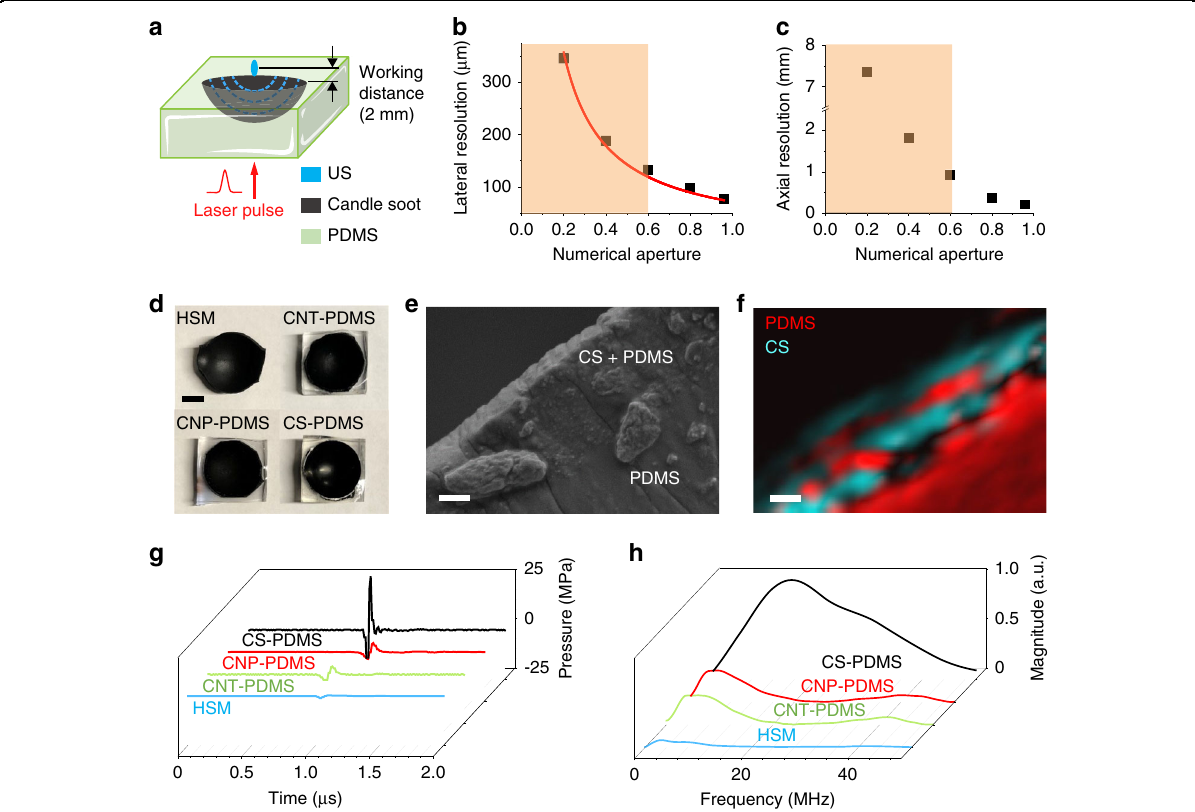
Fig. 1 Design, fabrication, and characterization of SOAP. a The schematic of SOAP design. b Numerical aperture and lateral resolutions. Red line: fi tting curve. Orange area: the NA range of conventional ultrasound transducers. c Numerical aperture and axial resolutions. d Photos of 4 kinds of SOAPs with the same geometric design. From left to right, top to bottom: heat shrink membrane (HSM), carbon nanotube-PDMS (CNT-PDMS), carbon nanoparticles-PDMS (CNP-PDMS), candle soot-PDMS (CSPDMS). Scale bar: 5 mm. e SEM image of the CS-PDMS SOAP cross-section. Scale bar: 1 μ m. f The spatial distribution of PDMS and CS in SOAP cross-section by SRS and photothermal imaging. Red: PDMS. Cyan: CS. Scale bar: 1 μ m. g Theultrasound waveforms from 4 kinds of SOAPs with the same laser energy input. h The frequency spectra of ultrasound from 4 kinds of